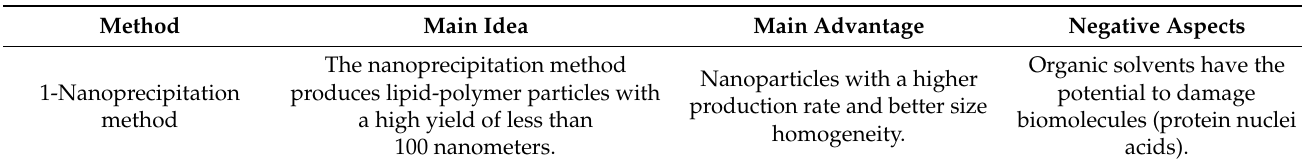
Table 1. The table represents different fabrication methods, in addition to describing the process, main advantage, and negative aspects. All information was taken from the following references